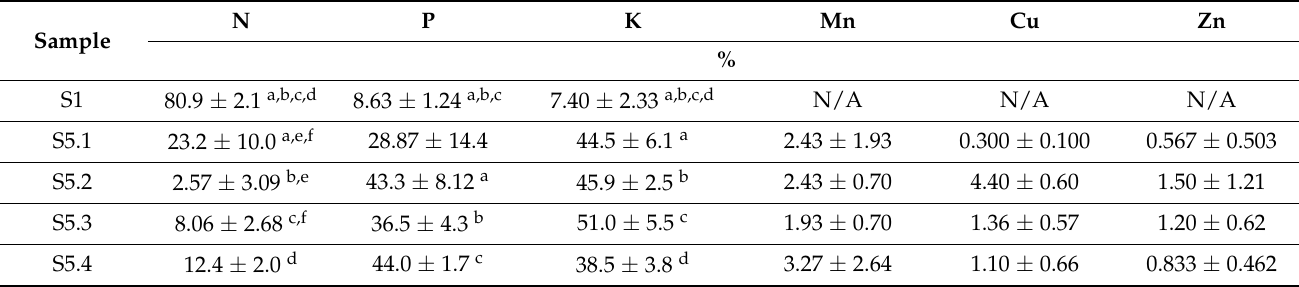
Table 6. Chemical composition of the microareas of the surface of the seeds, obtained by the energy dispersive X-ray analysis (S1—Uncoated seeds, S5.1—Seed coating containing a solution of 2% alginate with amino acids (37.6 mL/100 g), micronutrients (37.5 mL/100 g), and NPK, S5.2—Seed coating containing a solution of 2% alginate with amino